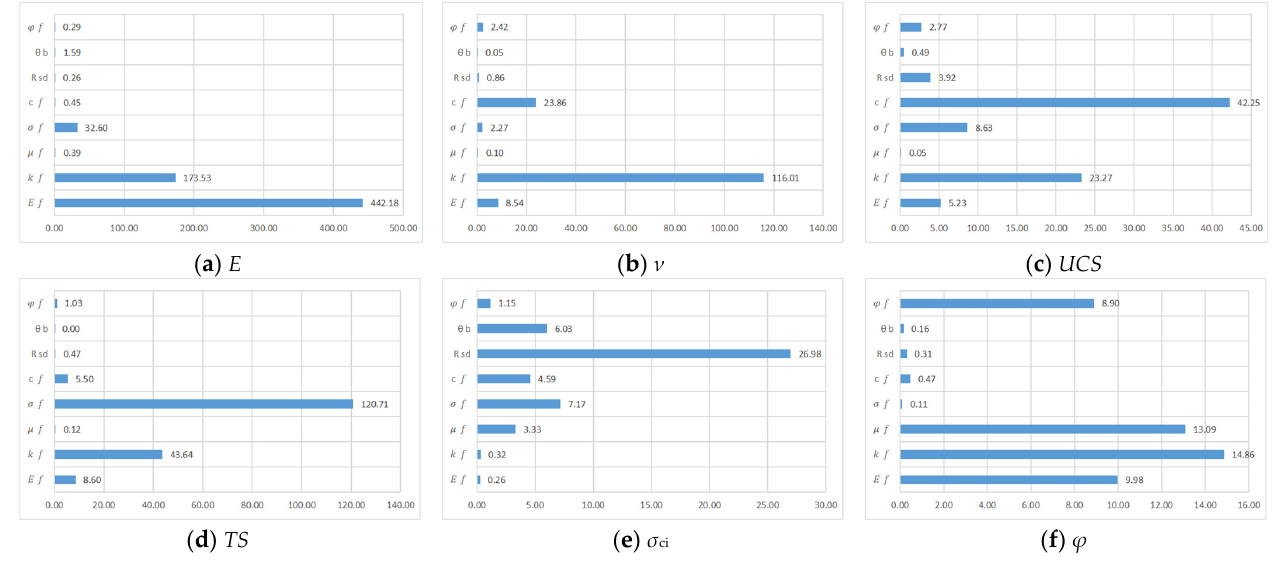
Figure 5. Analysis of variance F value of each microscopic parameter.